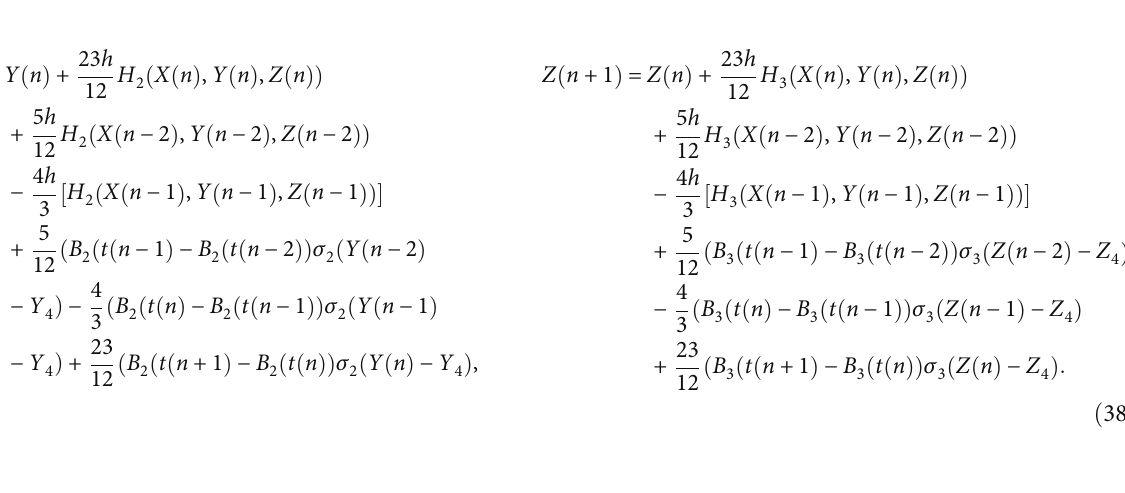
Figure 7: Time series trajectories of the piecewise systems (10) and (11) for c = 0 : 21 , c = 2 , K = 0 : 2 8